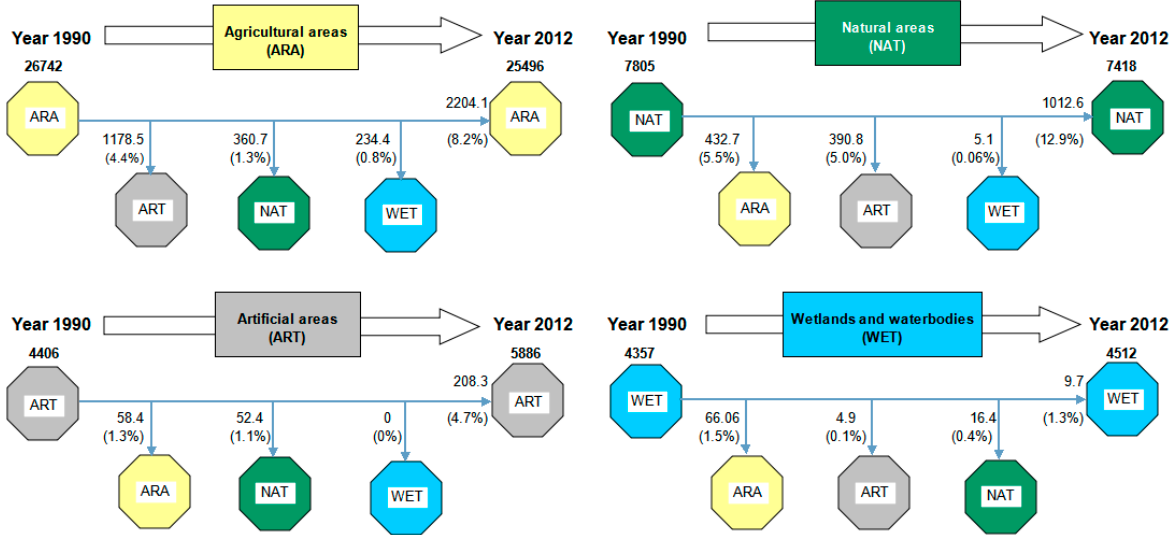
Figure 2. Sardinia. Detected land-cover/land-use changes within the 2-km buffer areas around 22 principal wetlands during 1990–2012, separately for agricultural areas (ARA), artificial areas (ART), natural areas (NAT) and wetlands/waterbodies (WET). Key to reading: 26,742 ha of ARA were present in 1990, of which 1178.5 ha (4.4%) changed to ART during 1990–2012. In addition, 2204.1 ha (8.2%) showed internal transitions (i.e., changes to a different CORINE land cover code belonging to ARA). In 2012, ARA amounted to 25,496 ha.